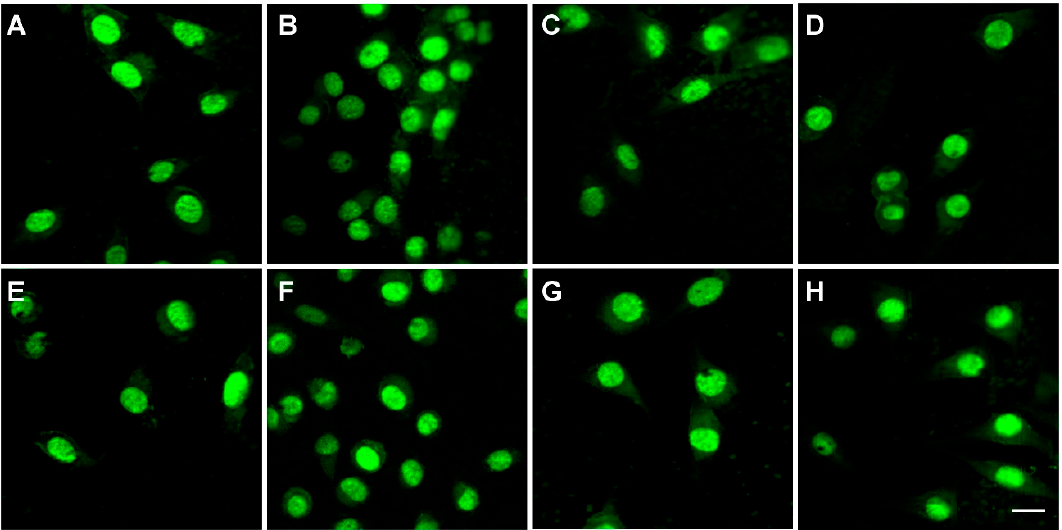
Figure 7. Morphology of fibroblasts in contact with the electrospun samples for 24 h: ( A ) Control, ( B ) PCL, ( C ) PCL-D-5%, ( D ) PCL-D-10%, ( E ) PCL-A-5%, ( F ) PCL-A-10%, ( G ) PCL-M-5%, and ( H ) PCL-M-10%.